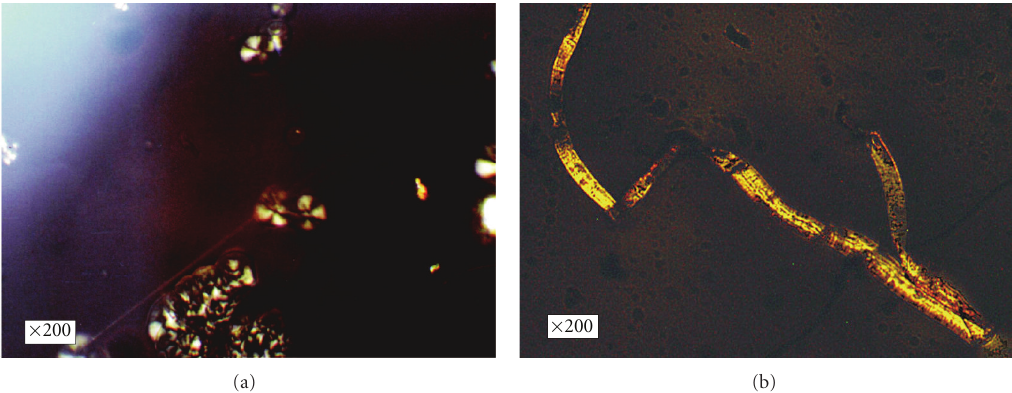
Figure 9: Photos of the CTA—nitromethane system in polarized light with no shear deformations applied: (a) denotes the mixture with C = 6wt% at T = 35 ◦ C; (b) C = 9 wt% at T = 45 ◦ C.